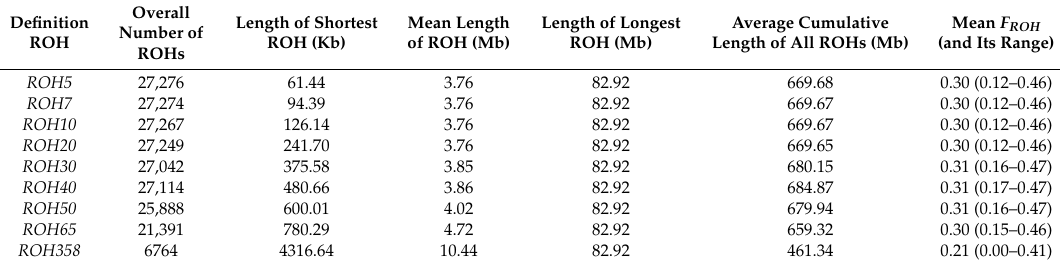
Table 3. Overview of the amount and length of runs of homozygosity (ROHs). A ROH was defined in nine different ways. For all definitions the number and length of detected ROHs per individual and detected consensus ROHs are given, respectively. The inbreeding coefficient F ROH was estimated for all definitions. In total, the genotyped Single Nucleotide Polymorphisms covered 2,201,666,442 bp of the autosomal dog genome.